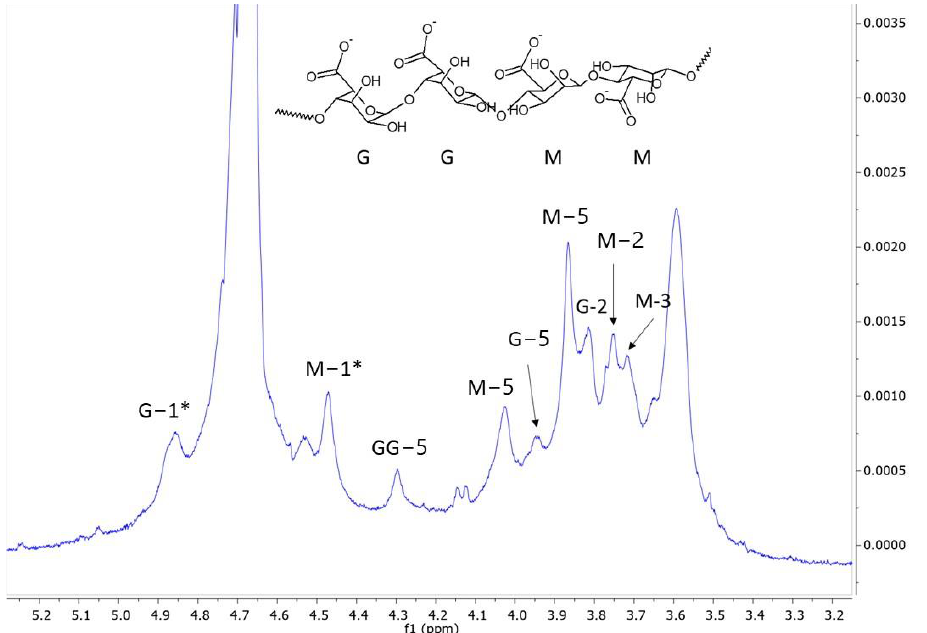
Figure 1. 1 H nuclear magnetic resonance spectrum with partial presaturation of residual H 2 O signal of sodium alginate (acquired from CIVEQ, Mexico City, Mexico) that was used to immobilize the Streptomyces strain (spores and mycelium). G − 1* and M − 1* indicate the anomeric hydrogen of glucuronic acid and mannuronic acid respectively.